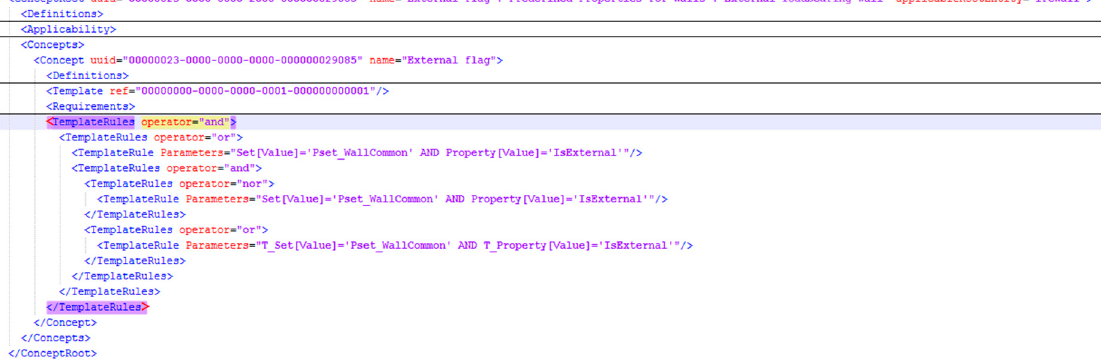
Figure 7. <Applicability> definition of a requirement.